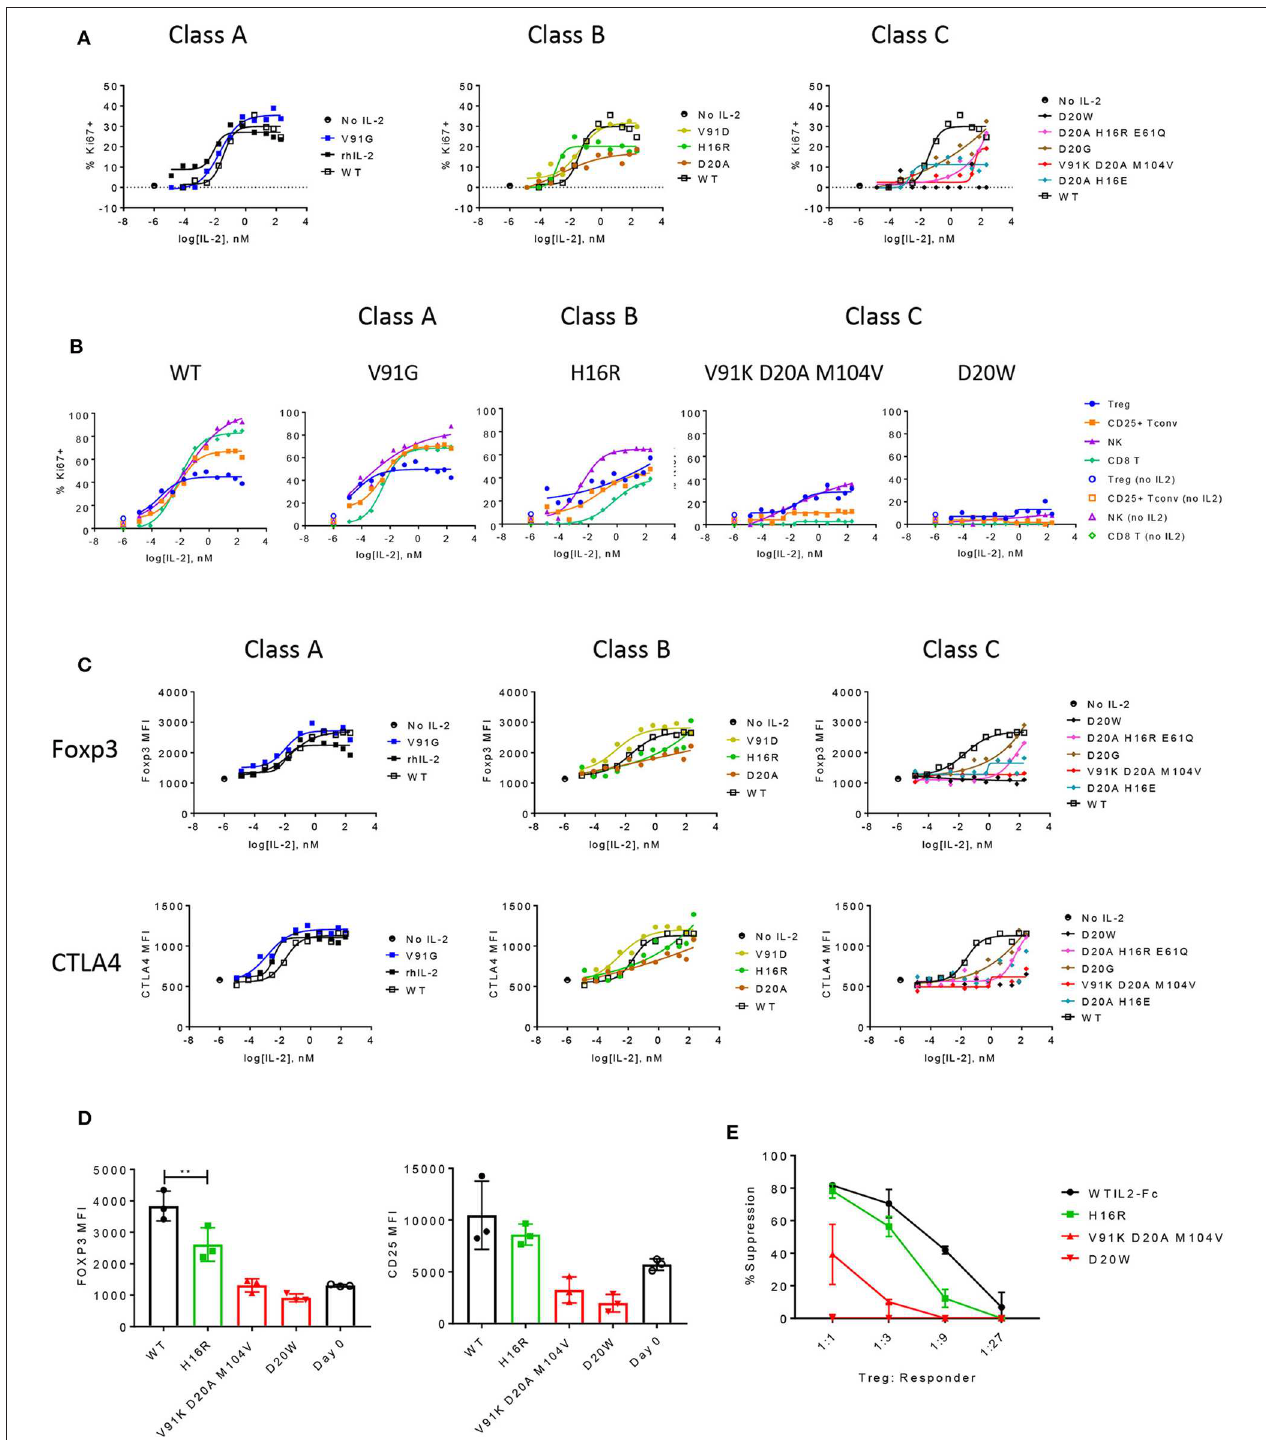
FIGURE 4 | The functional responses of Treg cells are quantitatively sensitive to attenuated IL-2 signal. (A) Proliferation of Treg cells in response to select muteins from each class was measured in human PBMC assay and shown as percent Ki67-positive cells in CD25 + Foxp3 + CD4-gated Treg cells. Shown are data representative of four donors. (B) Proliferative responses measured as percent Ki67 positives of Treg, CD25 + Tconv, NK (CD56 + CD3–), and CD8T cell gated subpopulations to increasing concentrations of wildtype or IL-2 muteins are compared in a total PBMC assay, for select muteins from each class. Shown are representative of data from four donors. (C) IL-2 mutein activity on induction of Foxp3 and CTLA4 in Treg cells are shown, represented as MFI of Foxp3 or CTLA4 in Foxp3-positive and